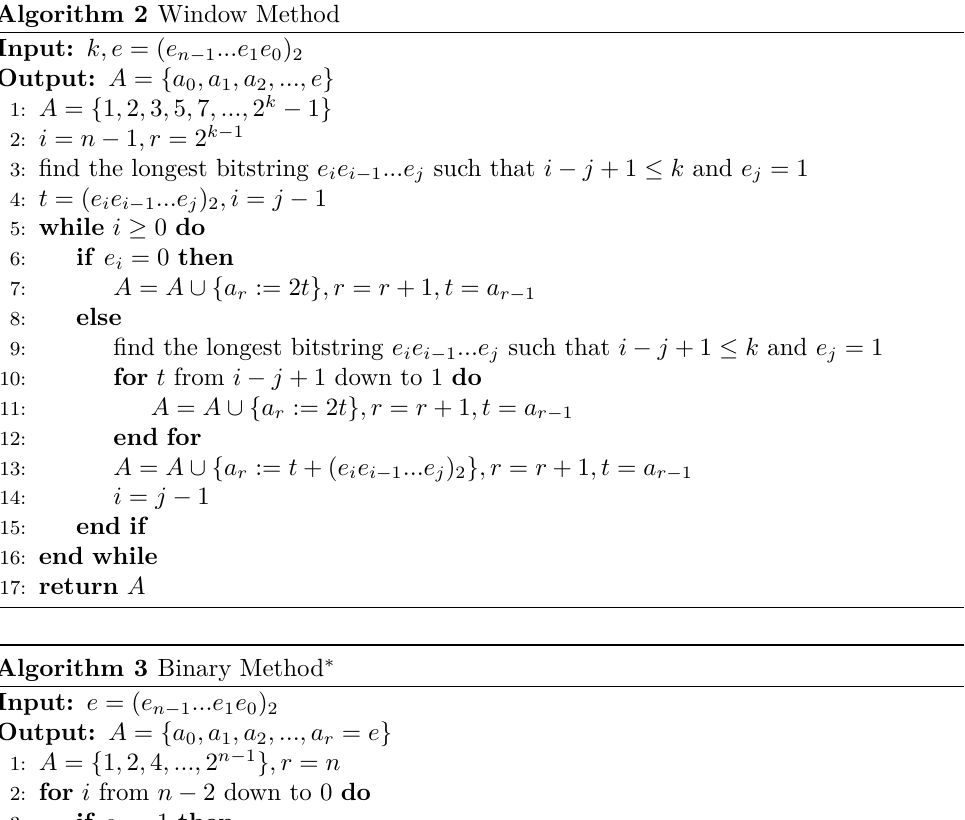
Algorithm 2 Window Method